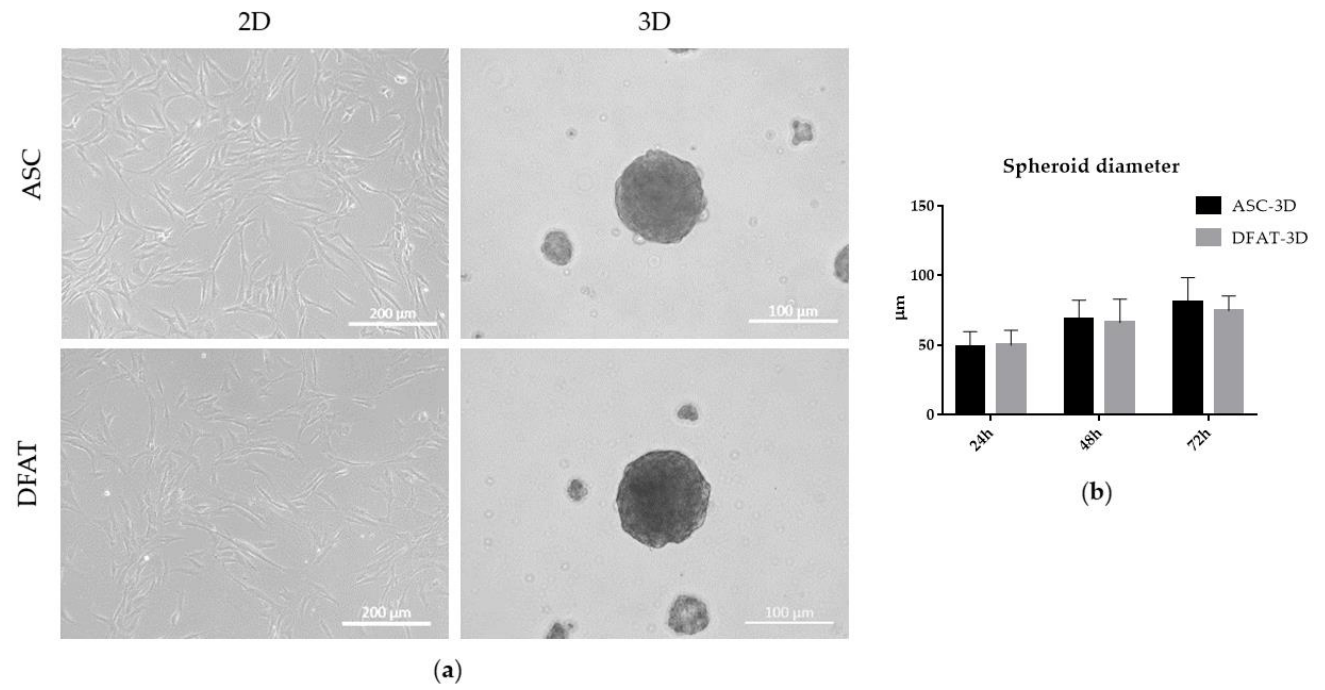
Figure 3. Assessment of ASCs and DFATs morphology cultured in 2D and 3D conditions. ( a ) Fibroblast-like (2D) monolayer ASCs and DFATs cultured on a standard plastic plate. Scale bar = 200 µ m and three-dimensional (3D) spatial cultures of ASCs and DFATs created on the anti-adhesive surface. Scale bar = 100 µ m; ( b ) Average spheroid diameter measured at 24, 48, 72, and 96 h of culture in ASCs-3D and DFATs-3D spheroids. The results are presented as mean values of 3 experiments ± SD .